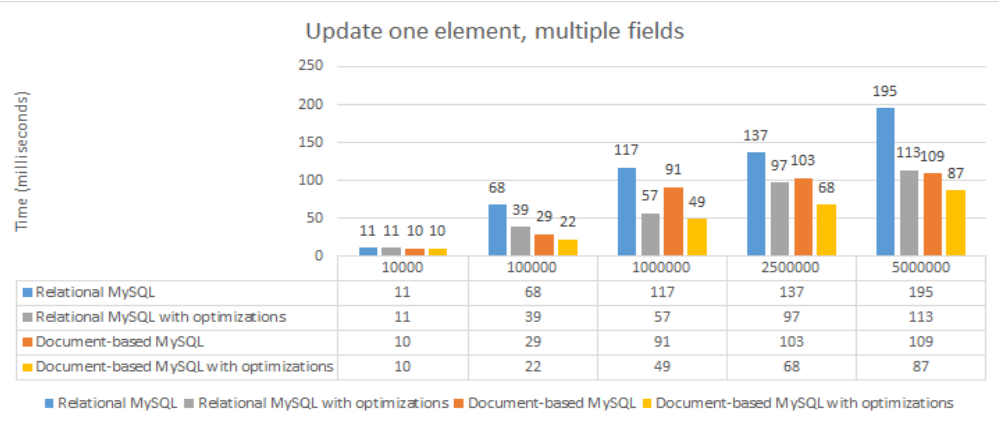
Figure 5. Performance time (ms) for the update one element but multiple fields operation.